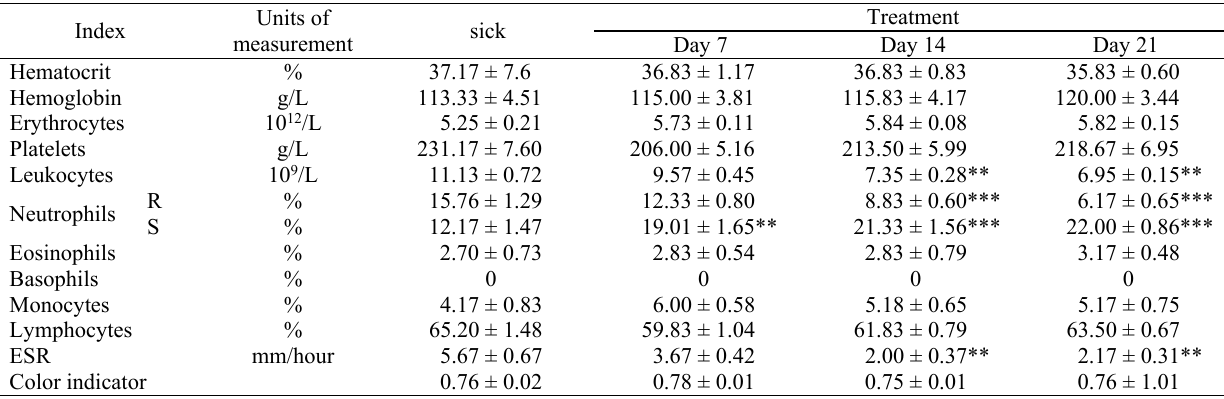
Morphological parameters of blood in guinea pigs in the treatment of microsporia with drugs “Micromar” and “Biogluk” ( М ± m, n =